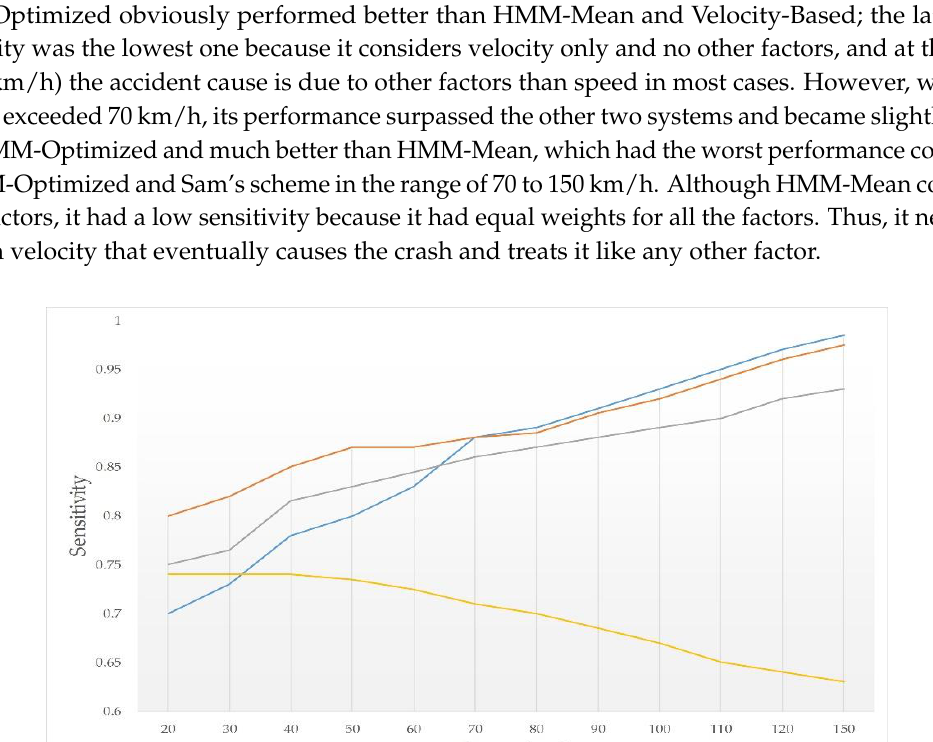
Figure 8. Velocity versus Precision.